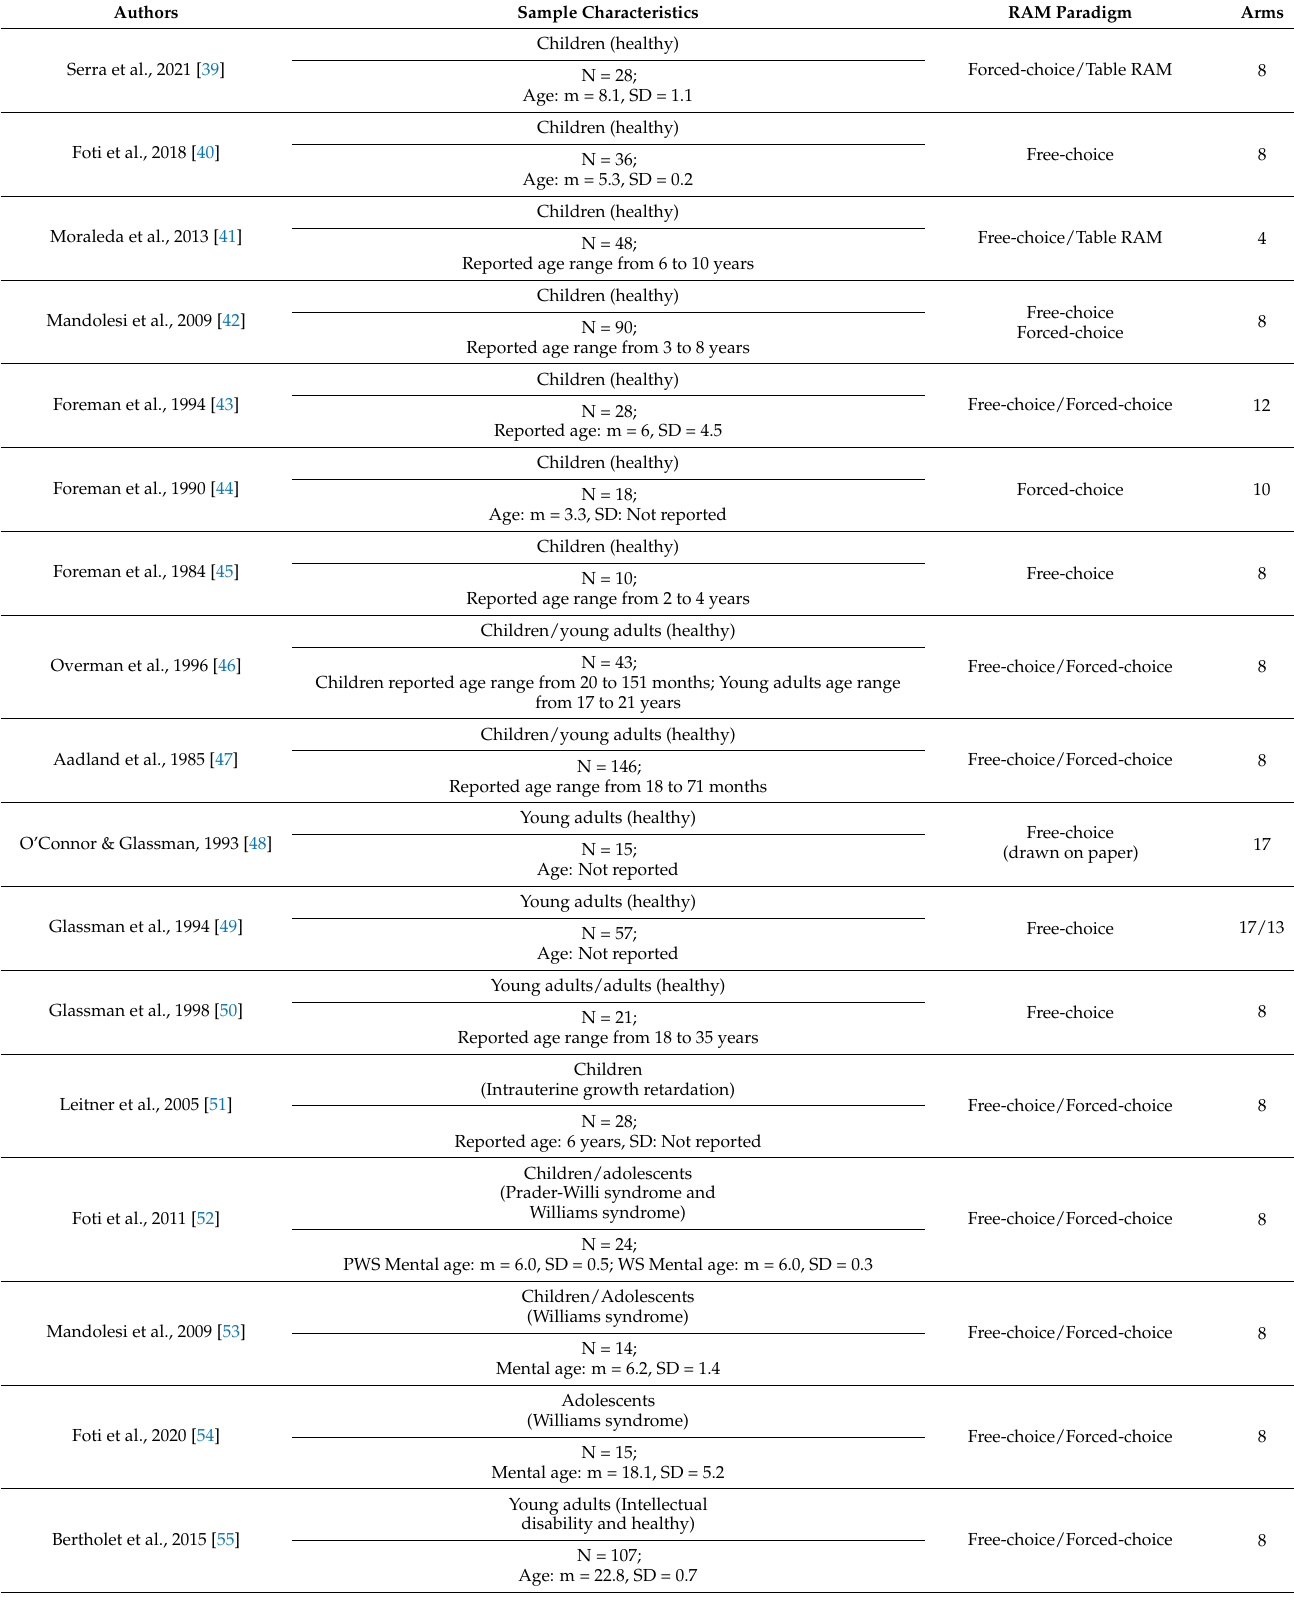
Table 1. Studies carried out using RAM in real